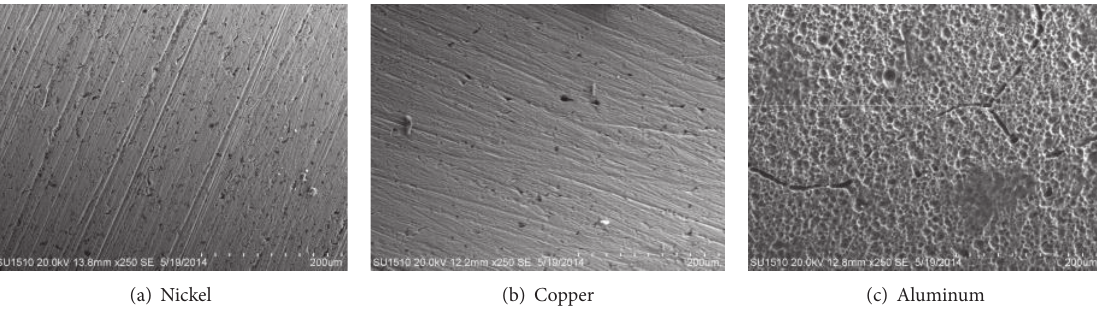
Figure 12: Micrograph of the corroded surfaces of (a) nickel, (b) copper, and (c) aluminum in 1.0 M H 2 SO 4 solution at 25 ∘